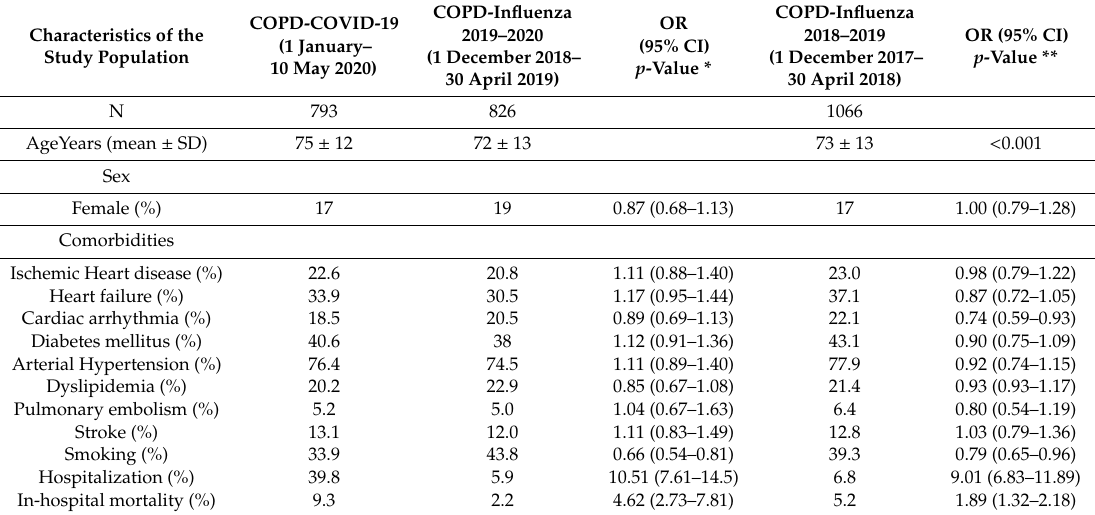
Table 2. Di ff erences in characteristics and clinical outcomes between COVID-19 and influenza in patients with